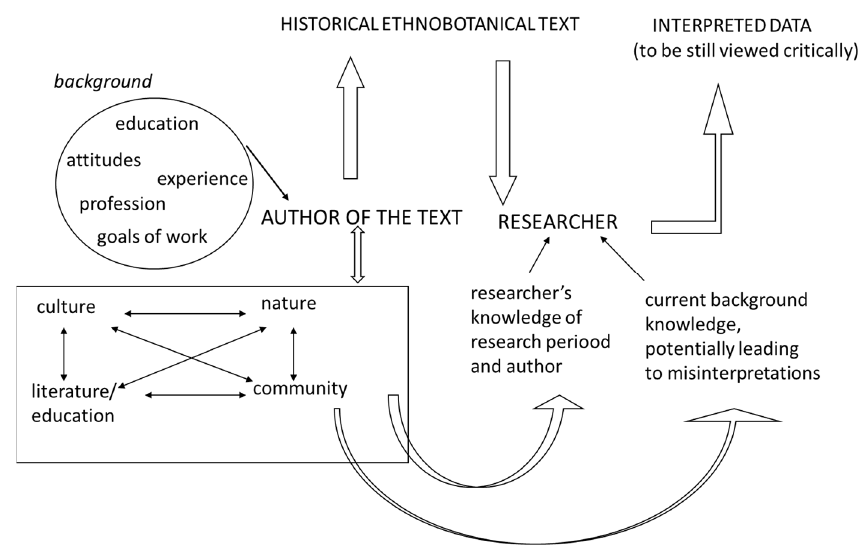
Figure 4. Aspects to consider when interpreting historical ethnobotanical works. Adapted from Sõukand